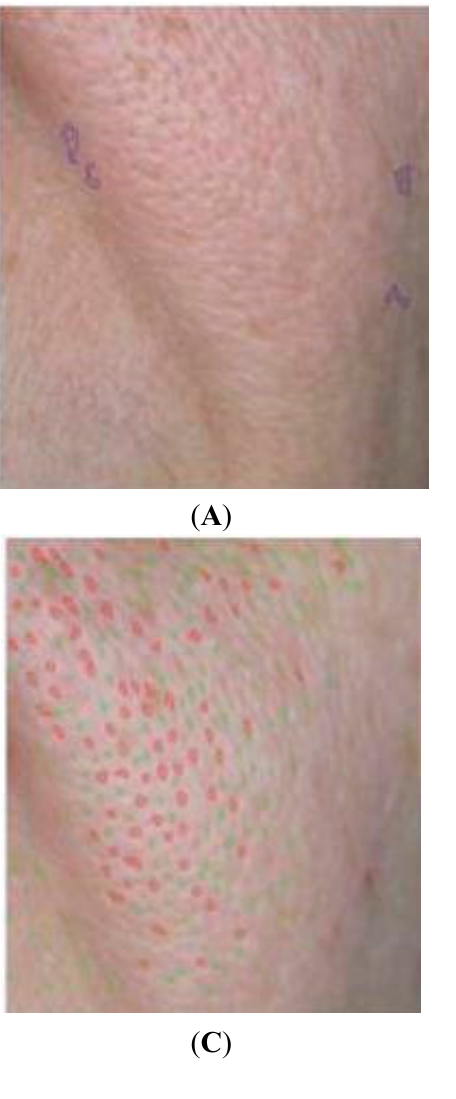
Figure 4. Illustrative images obtained with the digital photography imaging system: visible spots ( A ); wrinkles ( B ); pores ( C ); and spots visible only under UV light ( D